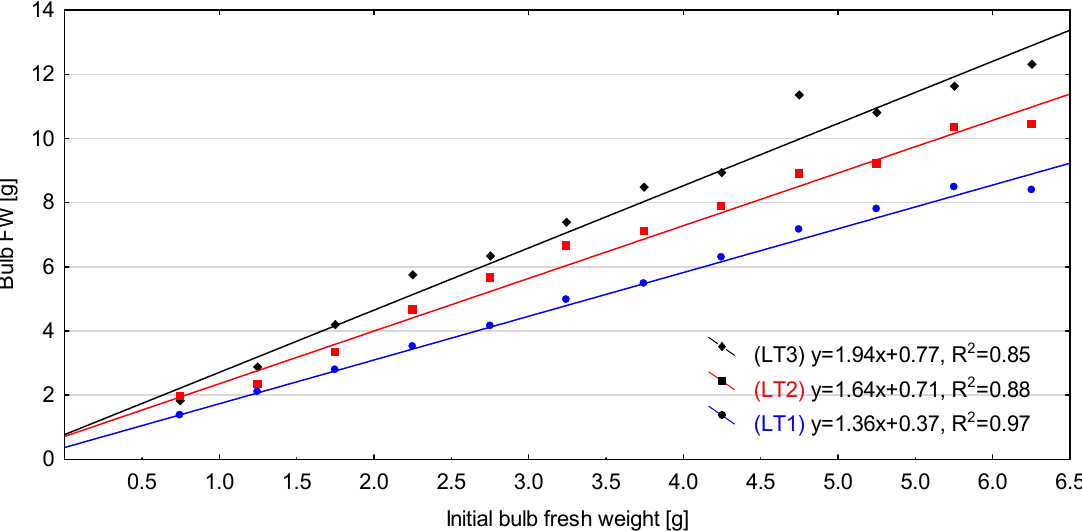
Table 4. Component loading of 11 traits, eigen values, proportion of total variability represented by the first two principal components (PC), cumulative variability in narcissus bulbs. Principal Component 1 Characters PC1